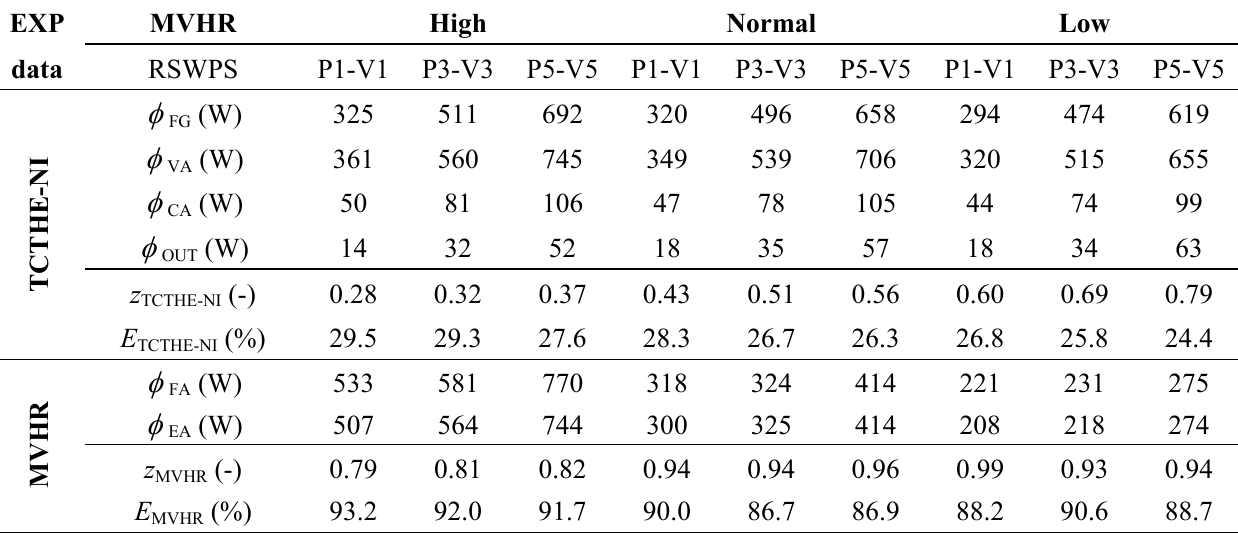
Table 4. Heat transfer rates and effectiveness within the TCTHE-NI and the MVHR unit. EXP MVHR High Normal Low